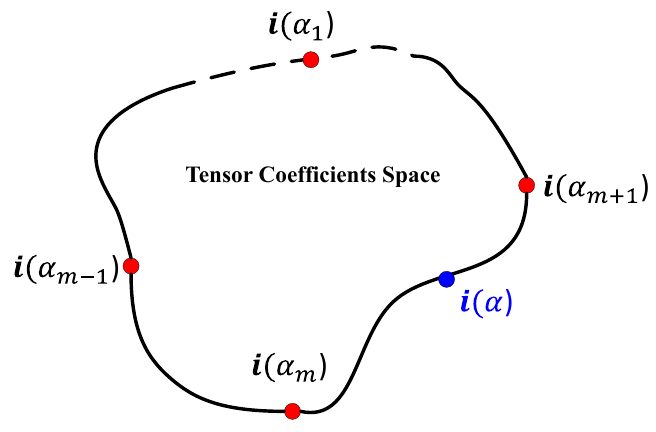
Figure 5. Cubic spline interpolation along the identity manifold in